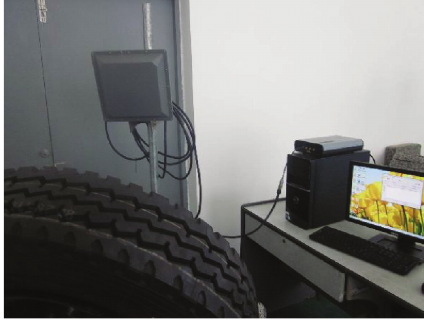
Figure 11: Experiment setup.